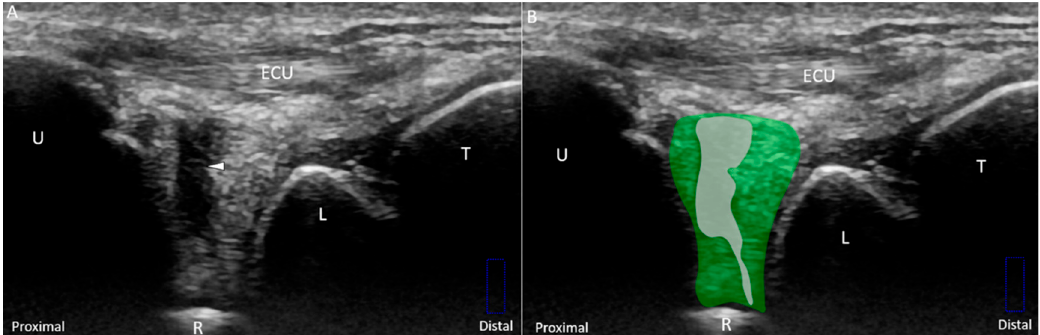
Figure 11. ( A ) US and ( B ) superposed US images show a longitudinal tear (white arrowhead and grey shade) extending through the entire diameter of the disc (green shade) , indicating Class 1D triangular fibrocartilage complex injury. The different color dashed rectangles are in accordance with the transducer positions in Figure 3. US: ultrasound; U: ulna; R: radius; L: lunate; T: triquetrum; ECU, extensor carpi ulnaris.